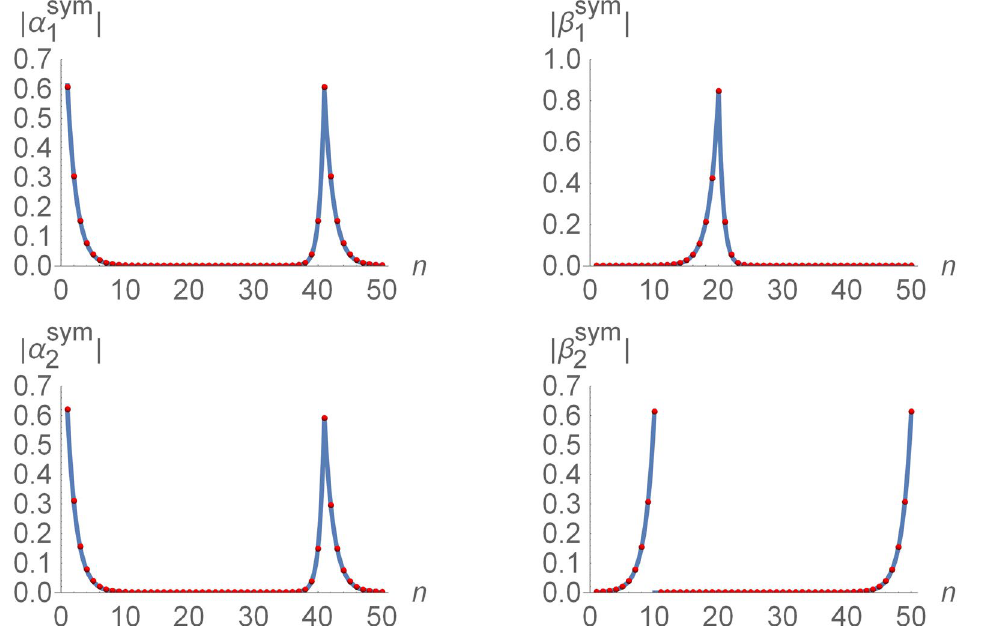
Figure 8. Majorana amplitudes of the two nearly zero-energy eigenstates of the modified Kitaev chain (27) with a T-junction in the piece-wise uniform applied field (3) with λ λ = = 1/2 , λ 2 = 4, N 1 = M = 20, N 2 = 10, and 1 3 N 0 = 11. The red dots represent the result of the exact numerical diagonalization. The solid curves are presented for comparison. The amplitudes α 1,2sym shown on the left two panels are compared with Eq. (20). The amplitude β 1sym appears to be well described by Eq. (17). The amplitude β 2sym of the Majorana zero mode localized at the junction point is given by Eq.